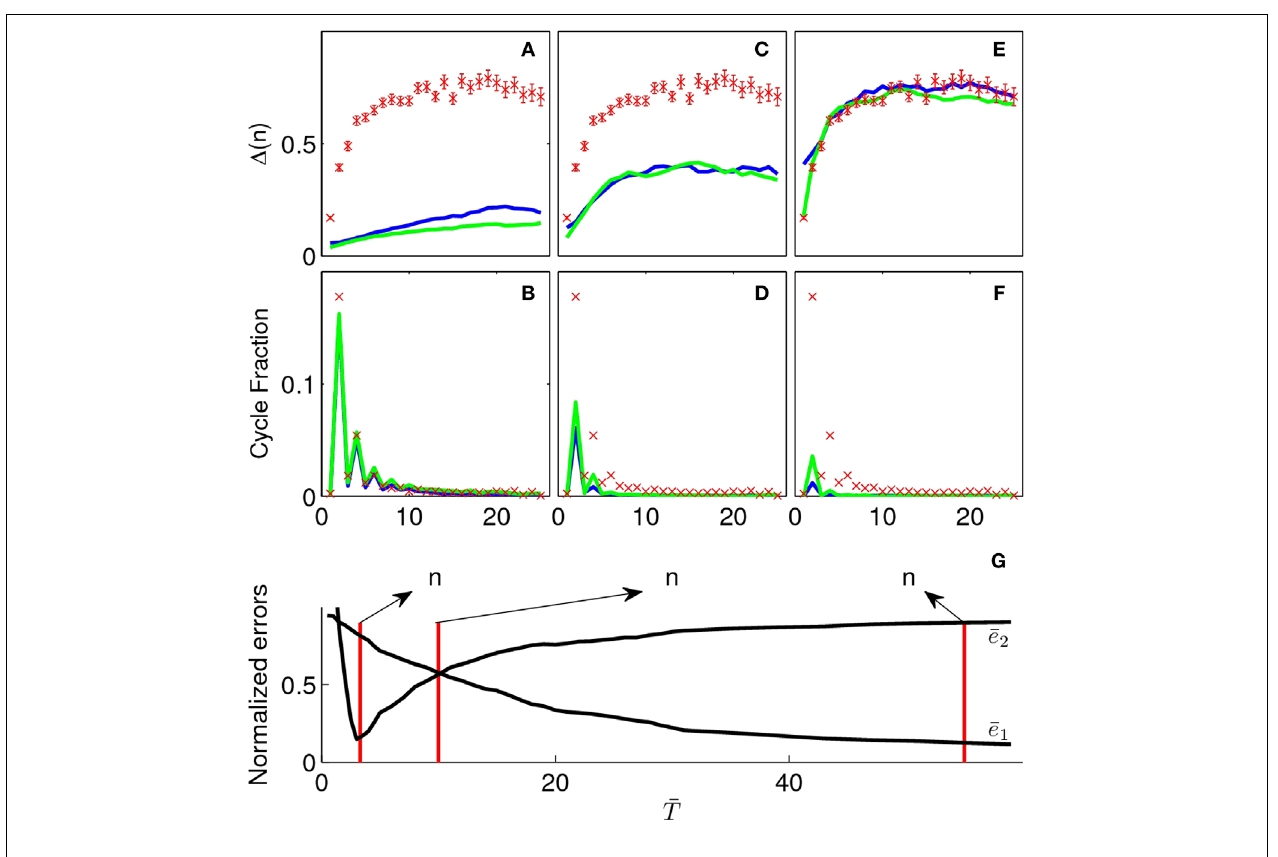
FIGURE 2 | In the upper part we present simulations of the kernel (blue) and exponential (green) models for different values of their parameter ( K and T ). (A) and (B) are simulations for a small value of the parameters K = 6, T = . 2 7. The cyclic structure is reproduced correctly but the diffusion is too slow. In (E) and (F) , the converse case is presented ( K = 60, T = . 66 6) now the diffusive behavior is captured correctly but the cyclic structure is not.